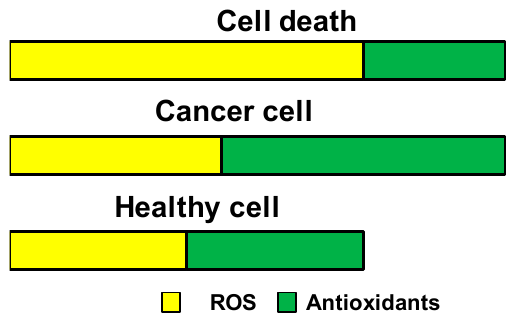
Figure 1. Schematic representation of ROS and antioxidants content in healthy and tumoral cells. The excess of ROS production observed in tumoral cells is counteracted by the production of more antioxidants. However, if the balance is lost, excessive ROS within cells will lead to cell death. The most representative ROS actors are superoxide anion radical (O 2 − ), hydrogen peroxide (H 2 O 2 ), and/or hydroxyl radical ( · OH). Superoxide anion is enzymatically